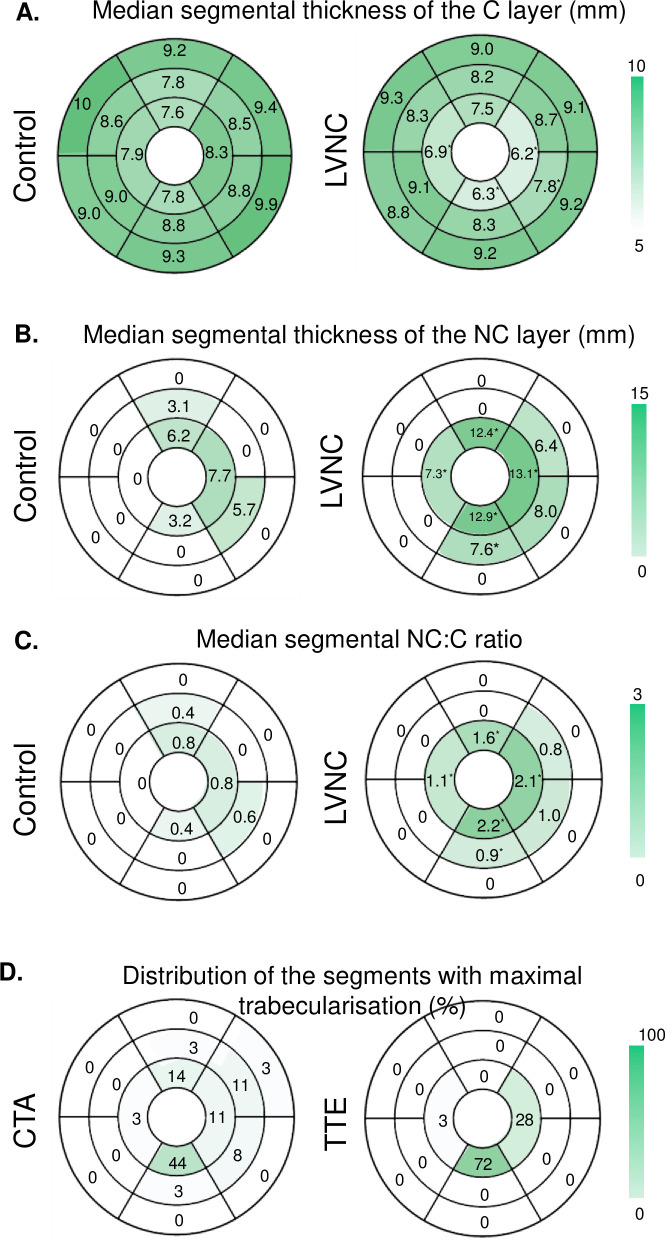
Polar plots.The polar plots are illustrating the median CCT segmental thickness of the C layer (mm) for the control (left) and LVNC (right) group (A). Basal segments 1–6 are shown in the outer layer, midventricular segments 7–12 in the middle layer and apical segment 13–16 in the inner layer (counterclockwise). The CCT segmental median thickness of the C layer was significantly lower in the LVNC group compared to controls in the inferolateral-midventricular, lateral-, inferior-, and septal-apical segments (*), whereas it did not differ significantly in the remaining segments. The polar plots are illustrating the median CCT segmental thickness of the NC layer (mm) for the control (left) and LVNC (right) group (B). Basal segments 1–6 are shown in the outer layer, midventricular segments 7–12 in the middle layer and apical segment 13–16 in the inner layer (counterclockwise). The CCT segmental median thickness of the NC layer was significantly higher in the LVNC group compared to controls in the inferoior-midventricular, anterior-apical, septal-apical, and inferior-apical, and latero-apical, segments (*), whereas it did not differ significantly in the remaining segments. The polar plots are illustrating the median CCT segmental NC:C ratio for the control (left) and LVNC (right) group (C). Basal segments one to six are shown in the outer layer, midventricular segments 7–12 in the middle layer and apical segment 13–16 in the inner layer (counterclockwise). The median CCT NC:C ratio differed significantly between LVNC and controls in the inferior-midventricular, lateral-, inferior-, septal-, and anterior-apical segments(*). The polar plots are illustrating the segments with maximal trabecularisation (%) for CCT (left) and TTE (right) (D). Basal segments one to six are shown in the outer layer, midventricular segments 7–12 in the middle layer and apical segment 13–16 in the inner layer (counterclockwise). The inferior-apical segment exhibited the most prominent trabeculations in both TTE (72%) and CCT (44%).